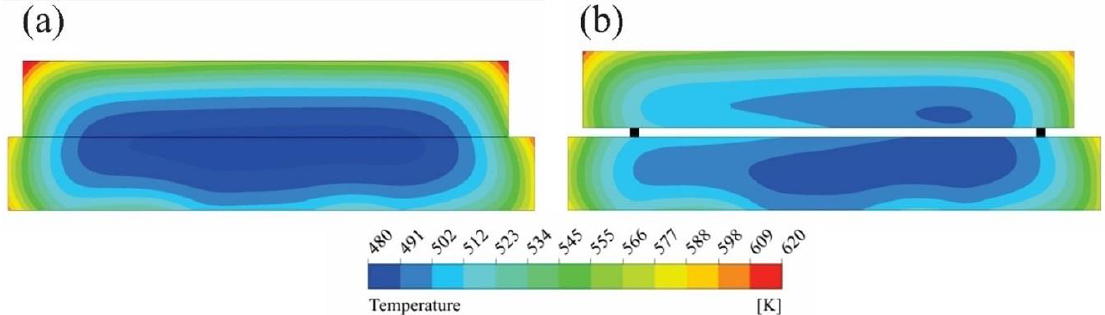
Figure 8. Contours of temperature distribution at the central cross-section of blocks at t/t T = 0.1 ( a ) Config-1-S0 and ( b ) Config-1-S5.